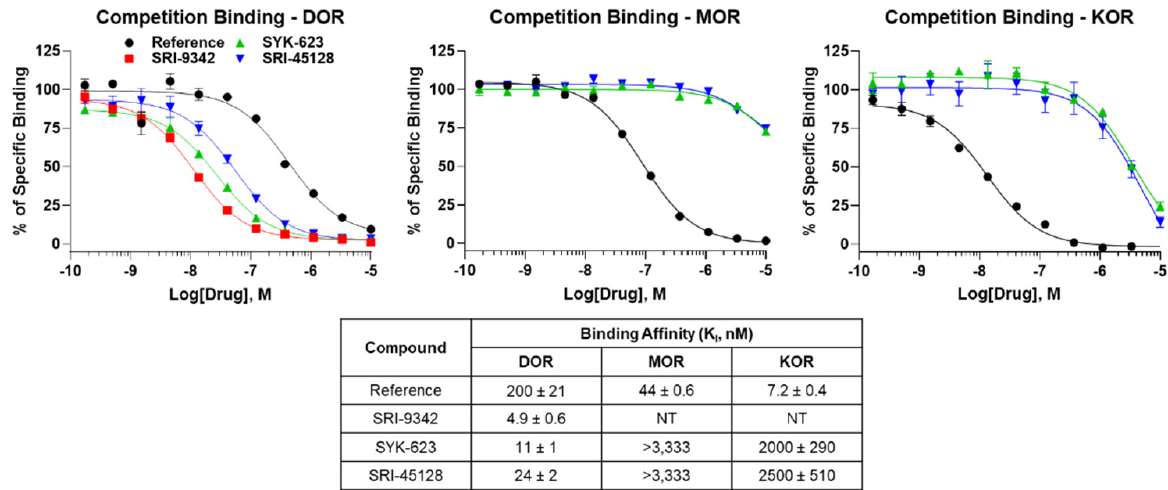
Figure 1. Novel compounds bound to the DOR with high affinity. Compounds were tested as concentration curves competing with a fixed concentration of 3 H-diprenorphine (see Methods). N = 3 independent replicates performed, with summary curves shown for each set; affinity (K I ) was calculated separately for each experiment and then reported as the mean ± SEM. Experimental or reference compounds (naloxone for MOR and DOR, U50-488 for KOR) were tested at each receptor, DOR, MOR, or KOR, as noted. Reference compounds displayed expected affinities, validating the experiment, while all compounds demonstrated high affinities at the DOR. SRI-45128 and SYK-623 showed poor affinity at MOR and KOR, suggesting strong DOR selectivity.